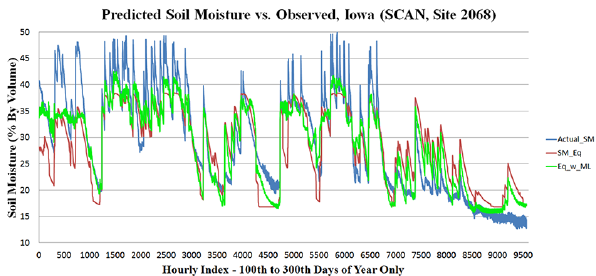
Figure 4. Soil moisture time series, SCAN site 2068, Iowa (USA), line colors from Fig. 3. Hydroclimate: ISCJ (intermediate seasonal- ity, semi-arid, winter peak runoff, summer peak precipitation). Soil texture: silty clay loam.